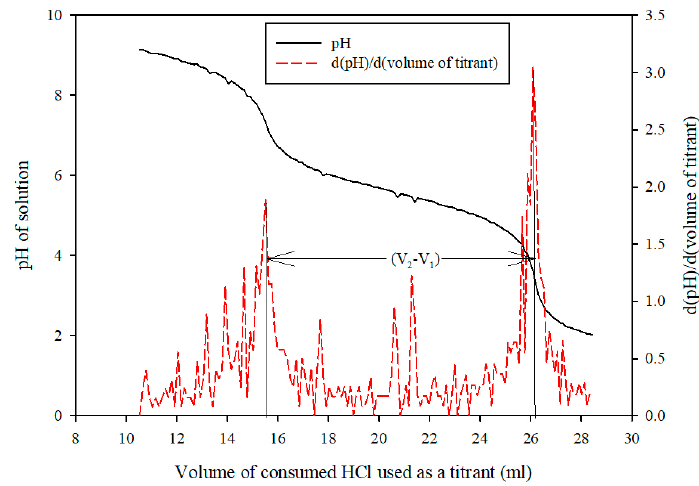
Figure 2. Plot of pH and its di ff erentiation versus volume of consumed titrant, (HCl), for the injection of 50 mL SO 2 through deionized